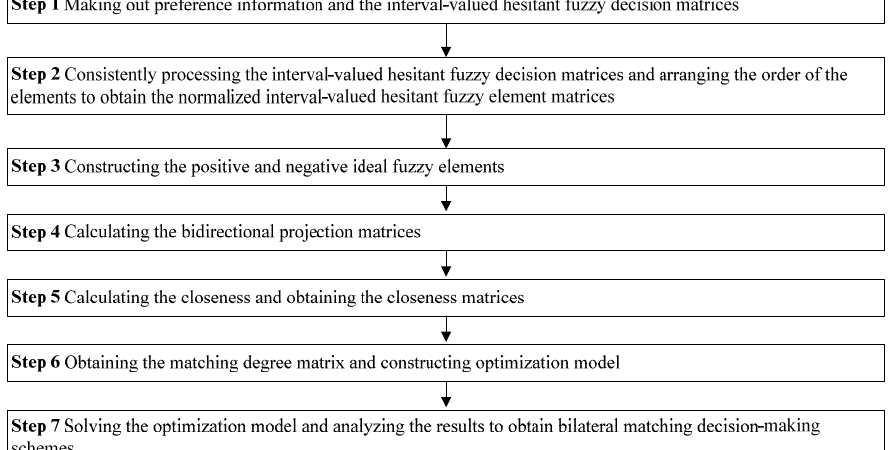
Figure 1. Process flow